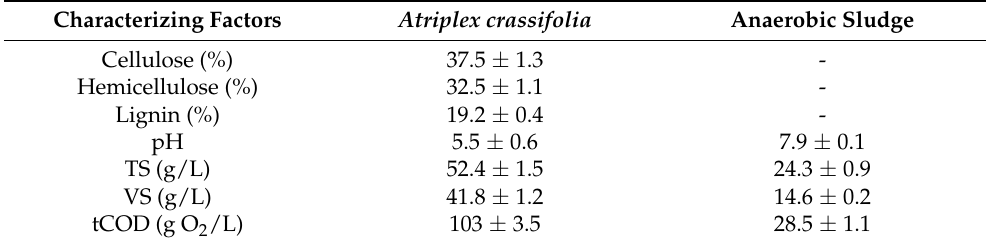
Table 1. Characterization of pre-hydrolyzed biomass and inoculum (anaerobic sludge). Characterizing Factors